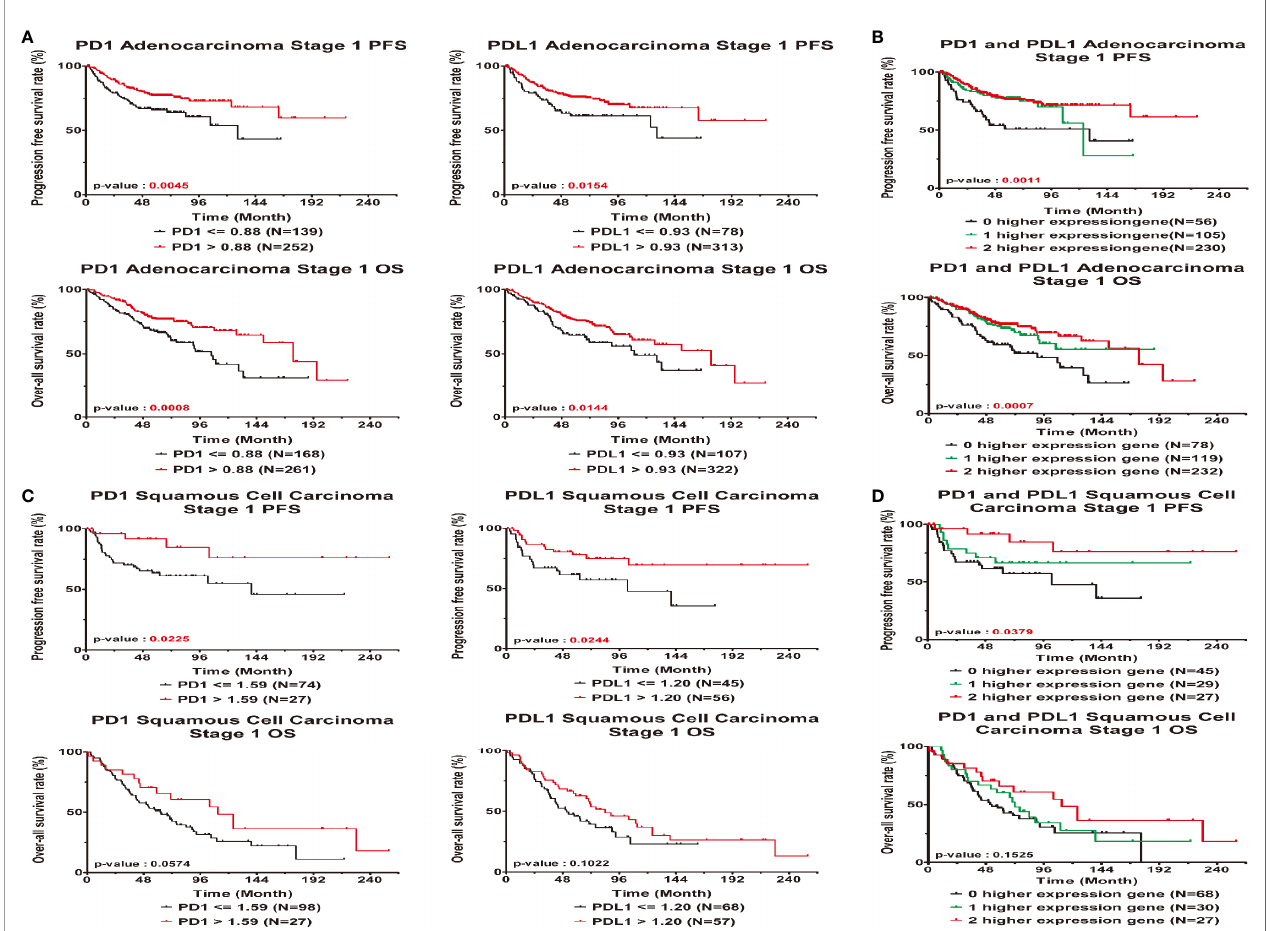
FIGURE 2 | Prognostic correlated with expression levels of PD1 or PDL1 in early stage lung cancer patients. Kaplan-Meier statistical analyses were conducted to examine the association between progression-free survival (top), over-all survival (bottom) and the expression of PD1 and PDL1 in adenocarcinoma (A) , squamous cell carcinoma (C) , the number of higher expressed genes (B, D) in all